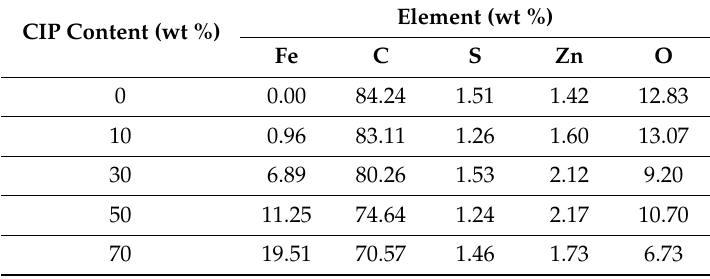
Table 1. Elemental result of ENR-based MREs for various wt % of